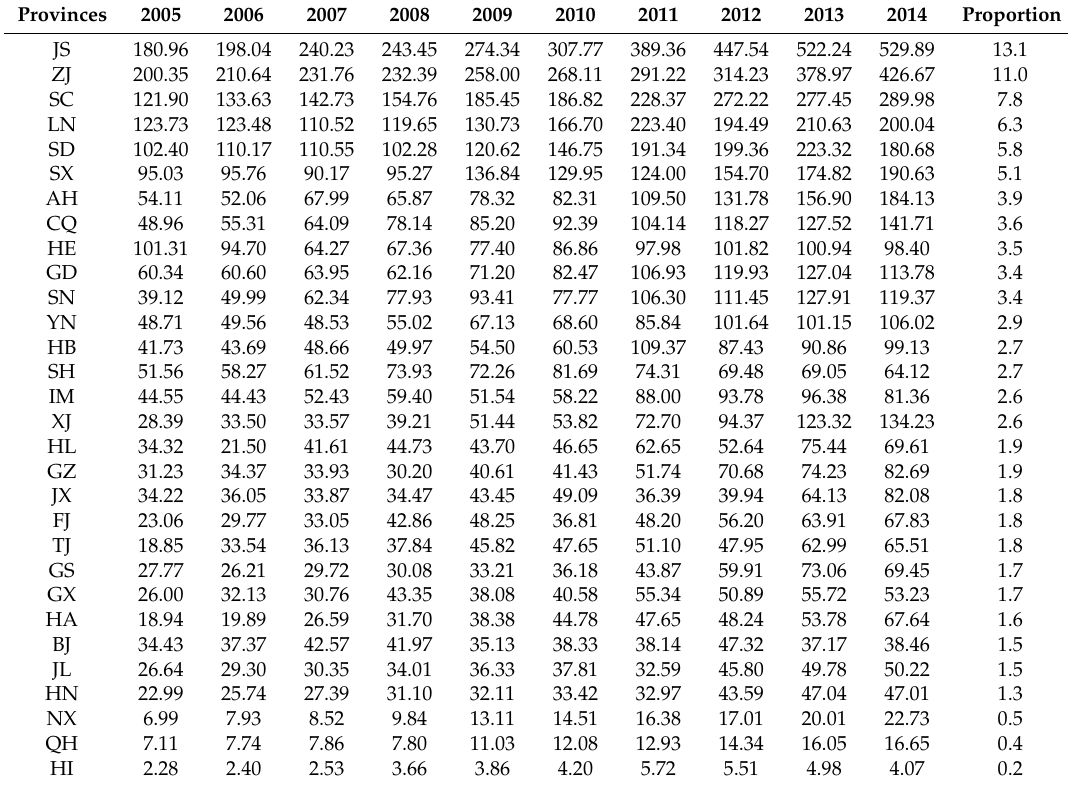
Figure 1. China’s provincial construction industry direct indirect carbon emissions ratio. Table 3. China’s provincial construction industry carbon emissions in 2005–2014 (Million tons).